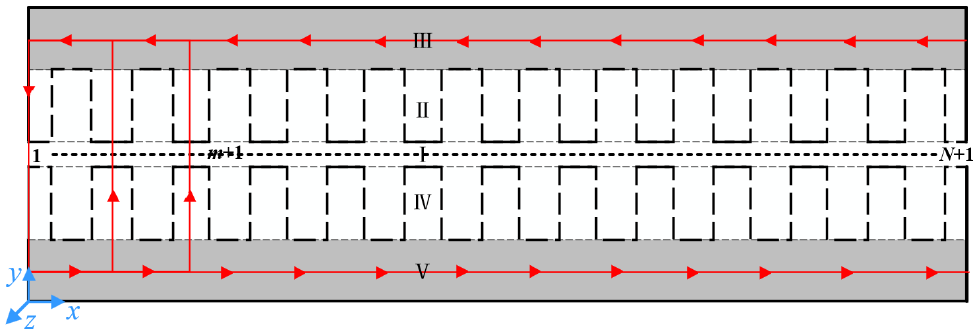
Figure 2. Schematic diagram of the block model of the UP-LPST. For the loop shown in Figure 2: